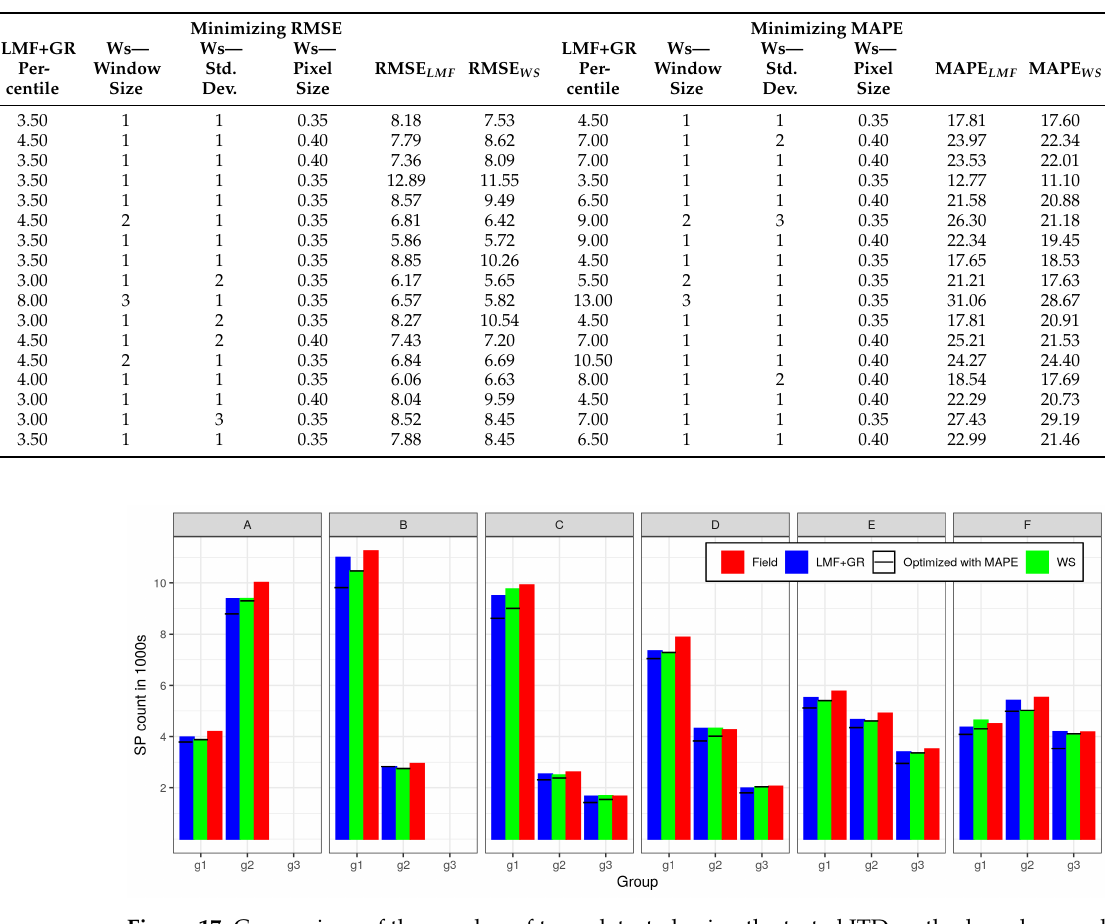
Figure 17. Comparison of the number of trees detected using the tested ITD methods and ground survey across categories and groups of circular plots ( A – F , g1–g3, see Table 2) in the variant of the experiment that ensures minimization of the RMSE metric (with reference to use of the MAPE